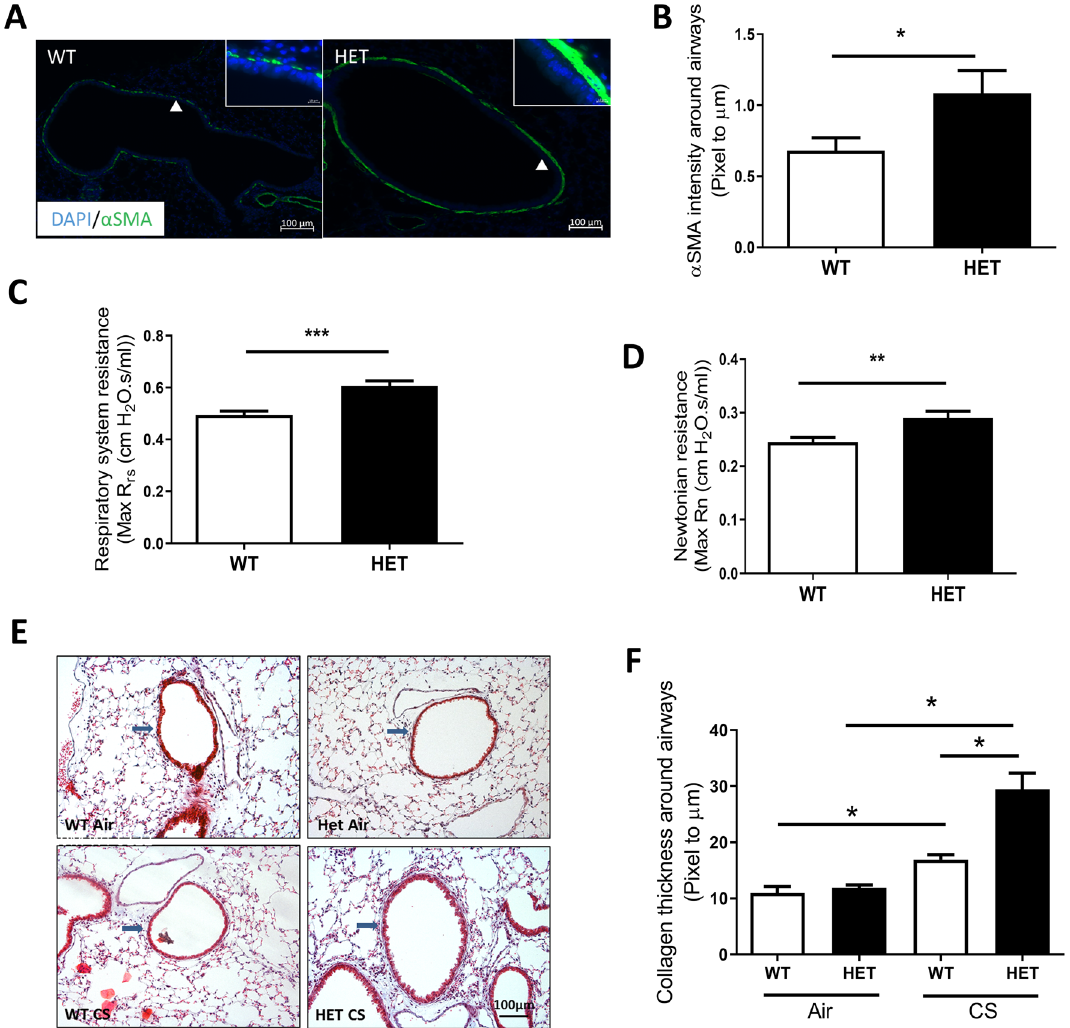
Figure 5. Immunostaining and lung function measurement in Hhip + /- (HET) and Hhip + / + (WT) mice. ( A ) Representative immunofluorescence staining of α-smooth muscle actin (SMA) in lung sections from Hhip + /- (HET) vs. Hhip + / + (WT) at the age of 8 months (Scale bars, 100 μm). Green color, α-SMA staining; Blue color, DAPI staining. Magnified figures from areas indicated by arrowheads are shown at the top right corner (Scale bars, 10 μm). ( B ) Quantification on α-SMA staining intensity around airways (N = 10–12 airways) in mice from each group (4–5 mice per group). Airways around 300–699 μm in diameter were chosen for quantification. Mean ± SEM are from airways (N = 10–12 airways) in each group. Lung mechanics including ( C ) Respiratory system resistance (Rrs) and ( D ) Newtonian resistance were measured in WT ( Hhip + / + ) and HET ( Hhip + /- ) mice at the age of 8 months (N = 14 vs. 19 mice). * P < 0.05 by Mann–Whitney test. ( E ) Trichrome staining in lung sections from 8-month-old female Hhip + / + and Hhip + /− mice with or without 6 months of CS exposure. ( F ) Quantification of Trichrome staining in murine airways (N = 10–12 airways) from each group (5–7 mice per group). Mean ± SEM are from airways (N = 10–12 airways) per group. Scale bars, 100 μm. WT, Hhip + / + mice; HET: Hhip + /- mice; CS, cigarette smoke. * P < 0.05 by one-way ANOVA. (Diameter of the airways assessed is 300–600